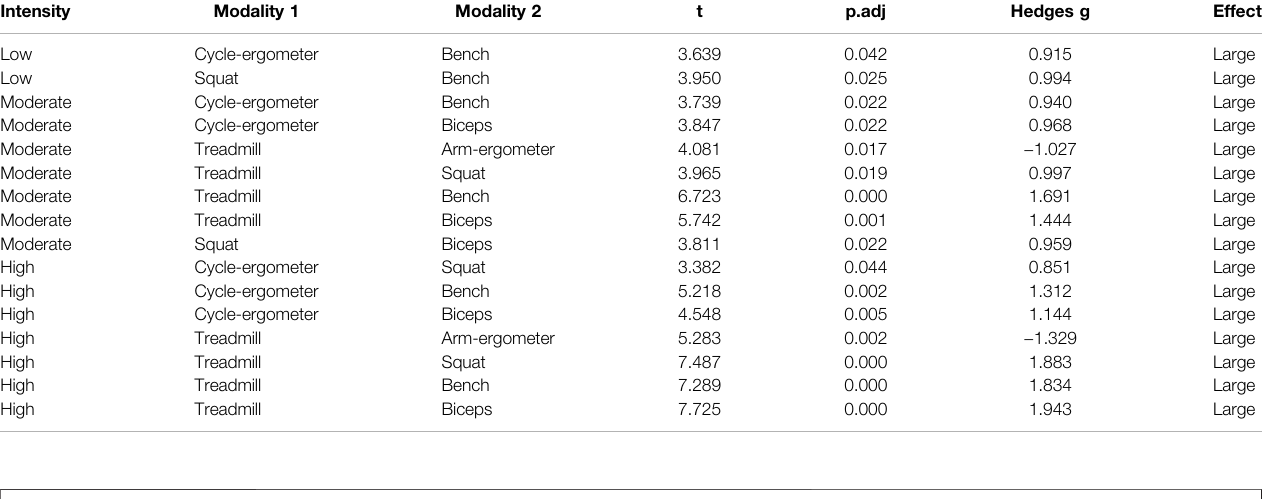
TABLE 3 | Pairwise comparisons between exercise modalities by exercise intensity for endothelial shear stress (ESS).